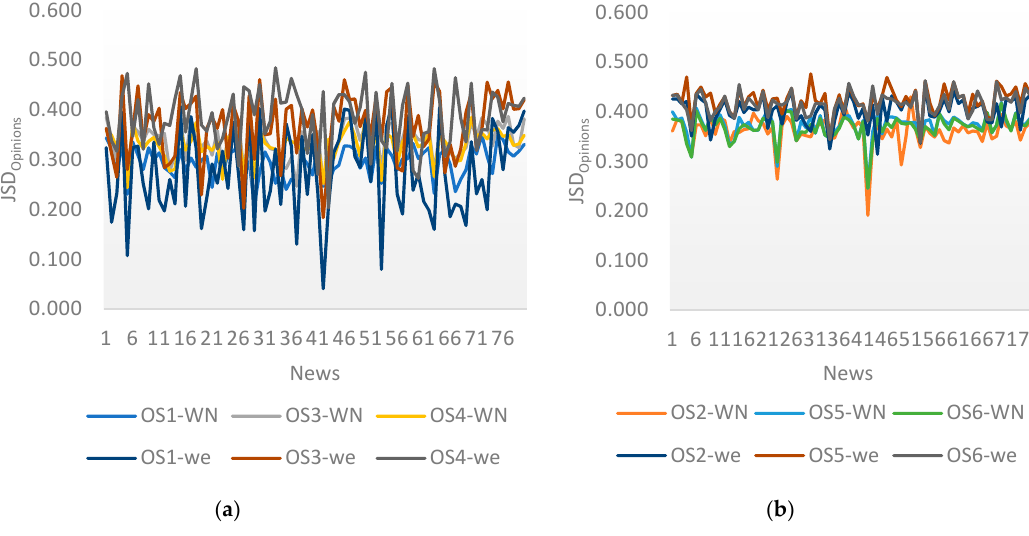
Figure 7. Results of JSD Opinions (Jensen–Shannon divergence focused on the opinions) applying ( a ) term and ( b ) sentence clustering, using WordNet and word embeddings on the TelecomServ dataset.